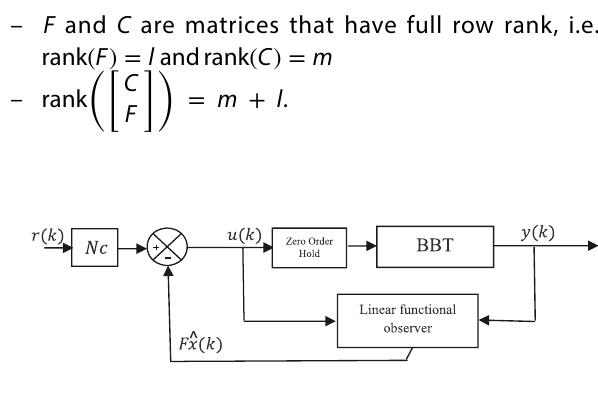
Fig. 5 A feedback control system with functional observer-based state feedback